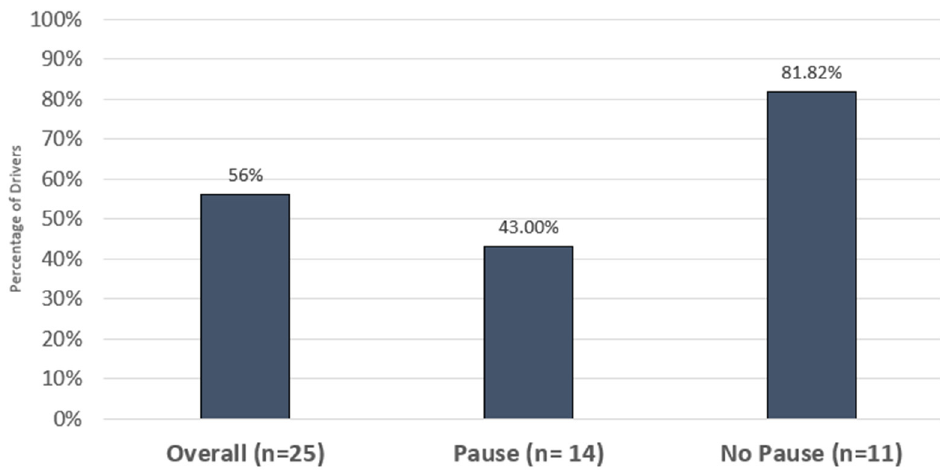
Figure 12. Percentage of drivers estimated to have been surprised by the muffler drop based on observer video analysis.